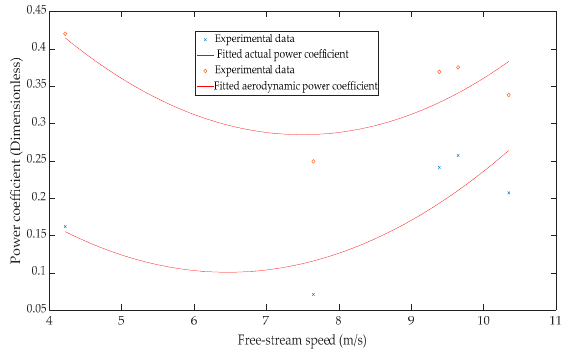
Figure 11. Power coefficient as a function of the free-stream speed.